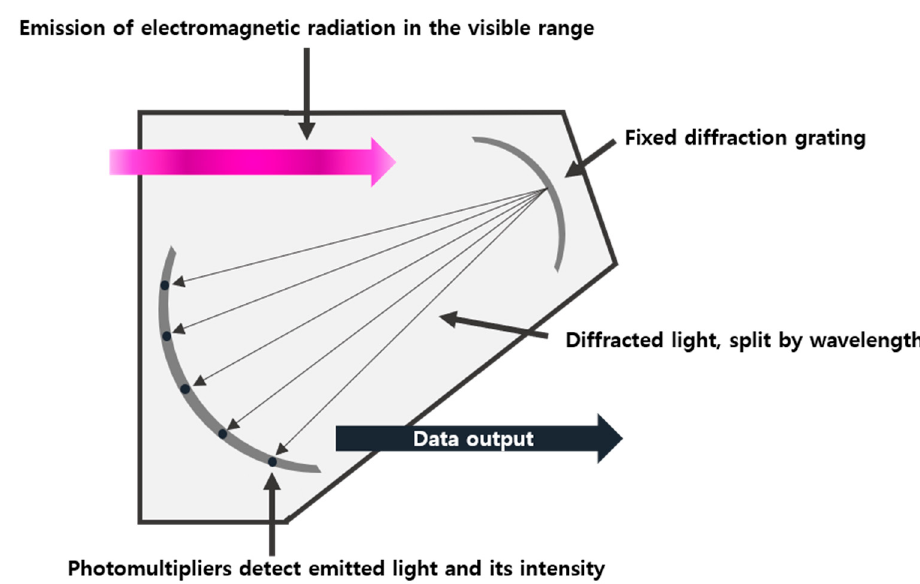
Figure 2. Schematic of optical emission spectroscopy.